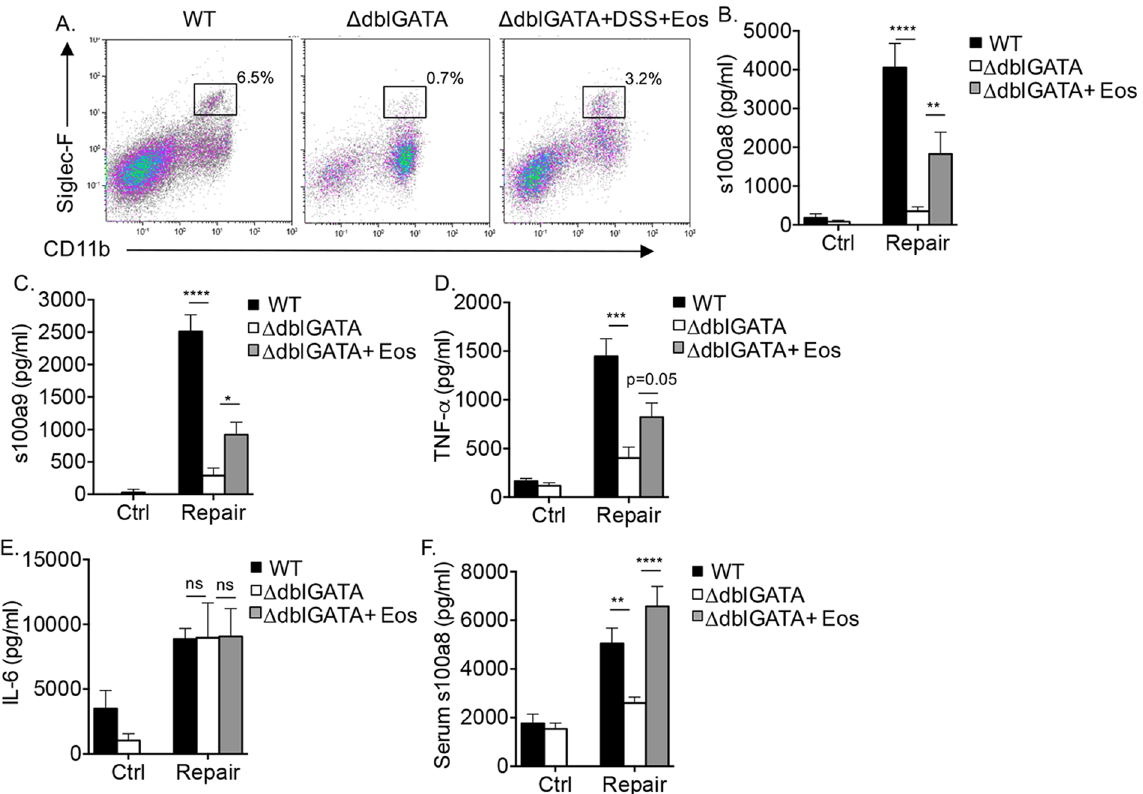
Figure 6. Increased local and systemic expression of s100a8 and s100a9 during mucosal healing is eosinophil- dependent. Eosinophils were adoptively transferred into eosinophil deficient ( ∆ dblGATA) mice during the induction of inflammation by DSS. Gating strategy demonstrating eosinophil levels in wild type (WT) mice, ∆ dblGATA mice and ∆ dblGATA mice, which received eosinophils during the course of DSS treatment ( ∆ dblGATA + DSS + Eos). Thereafter, the expression of s100a8 ( B,E ) s100a9 ( C ), TNF- α ( D ) and IL-6 ( E